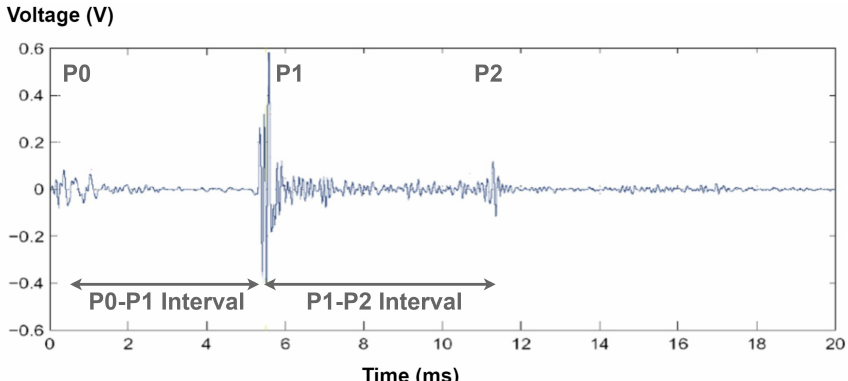
Figure 2. Physeter Macrocephalus click